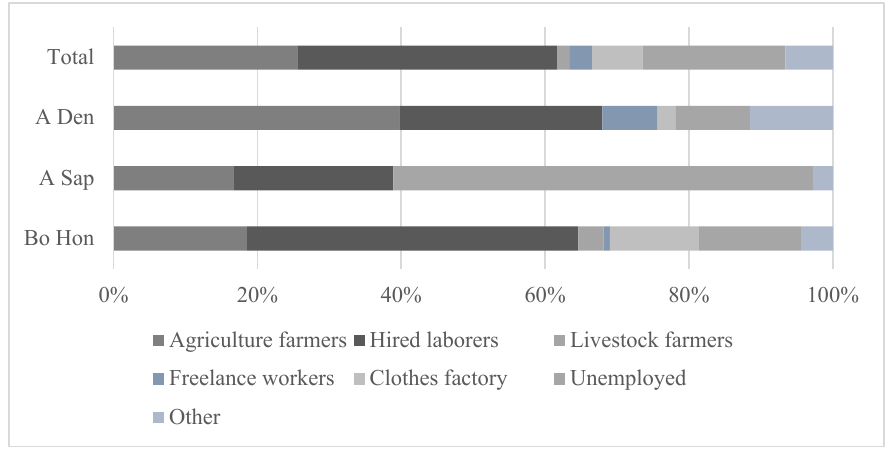
Figure 3. The distributed proportion of main income sources of the surveyed households.